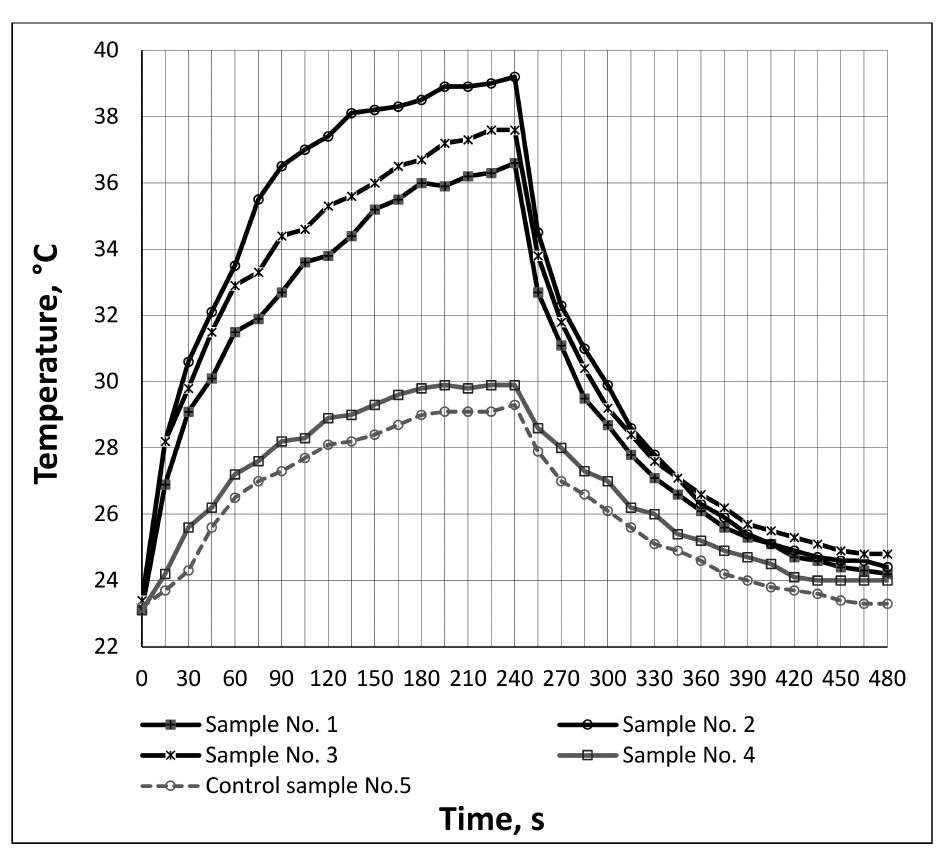
Figure 6. Dynamic curves of the heat accumulation/release generated by IR rays of different struc- tures of